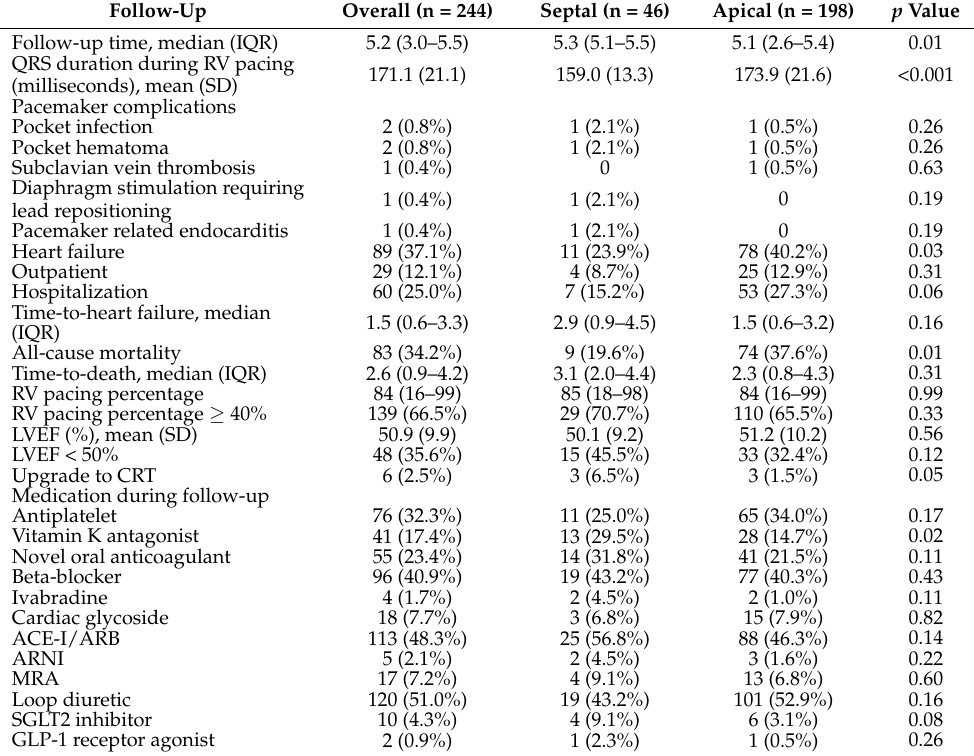
Table 2. Follow-up characteristics of studied population, by the location of the right ventricular pacing lead. Follow-Up